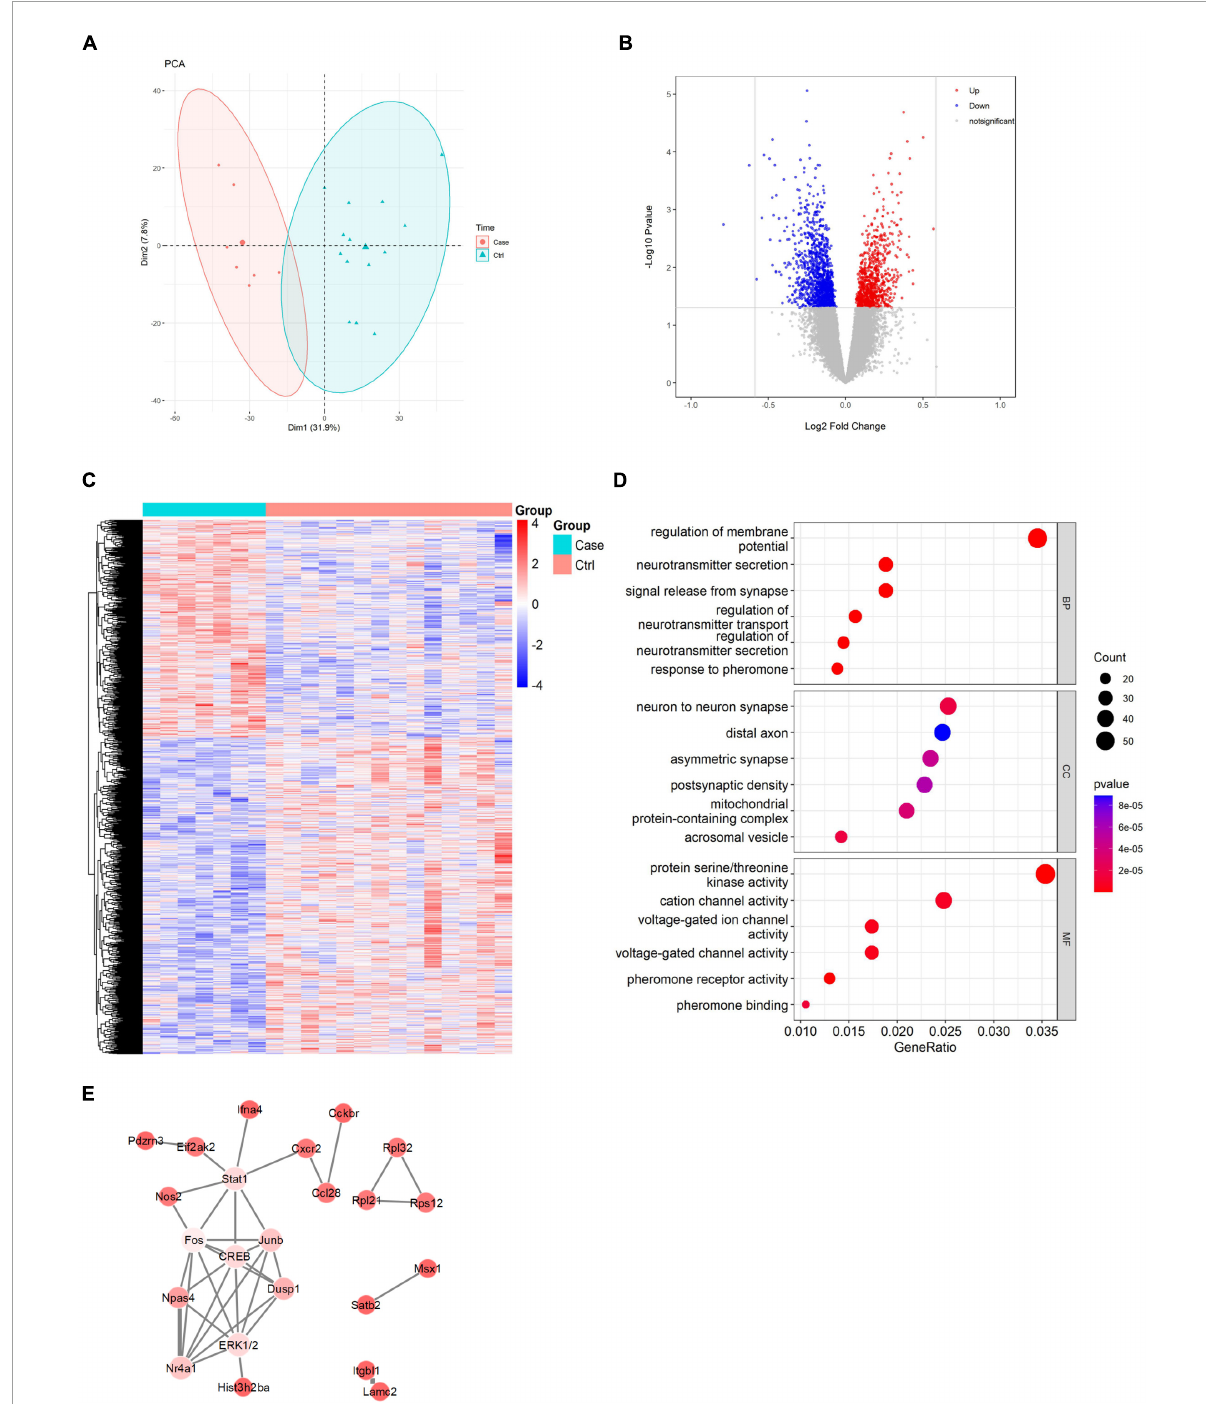
FIGURE2 Results of bioinformatics analysis. (A) Principal component analysis diagram. (B) Differential gene volcano map. (C) Heatmap of differential gene cluster analysis. (D) GO enrichment analysis pathways. (E) Interaction network diagram of Top100 DEGs.